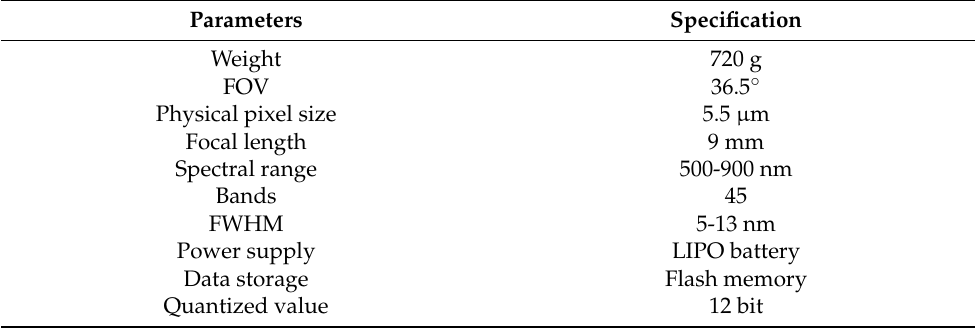
Table 2. Rikola camera: specifications and selected sensor settings for this